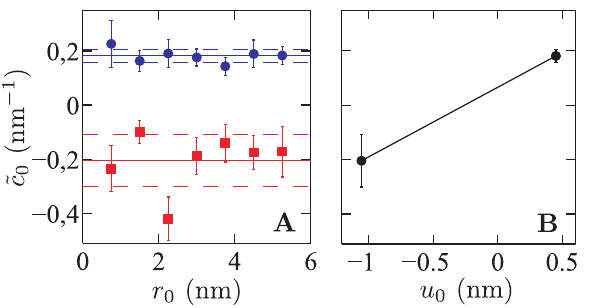
Figure 6. Renormalized spontaneous curvature ~ cc 0 versus the relative volume variation v ( r 0 ) = v 0 on the inclusion edge. The values of ~ cc 0 are extracted from fitting the data of Ref. [15], and the values of v ( r 0 ) = v 0 are directly taken from Ref.